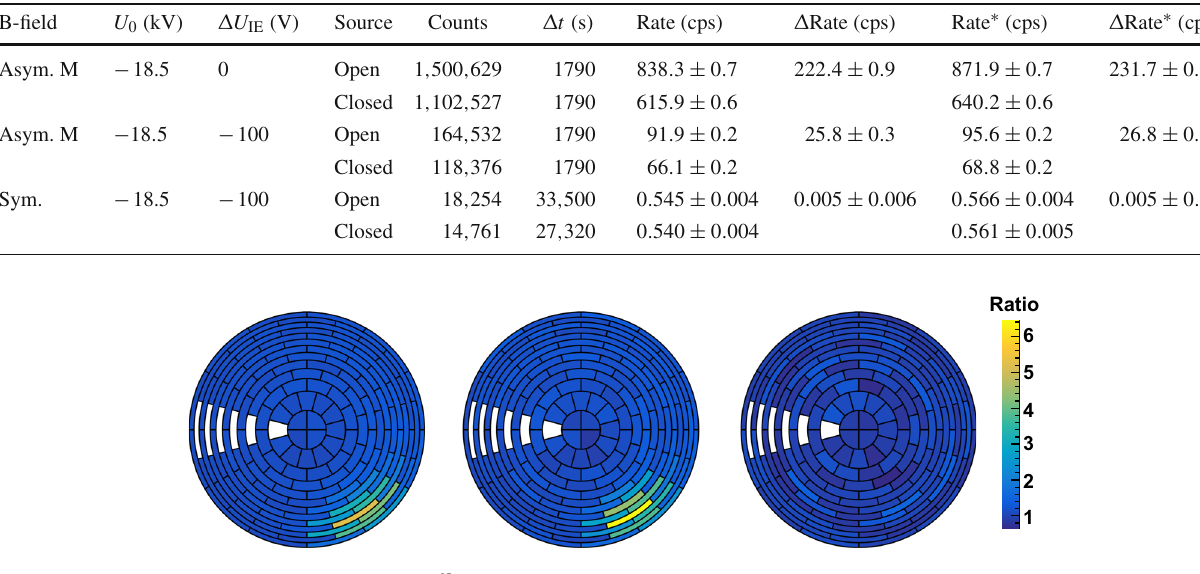
The detector is being viewed from the FPD end of the beamline. The six white pixels were excluded due to a broken preamplifier module. The total FPD rate with the closed source is 683.3 cps (73.7 cps) (0.540 cps) for the left (center) (right) panel